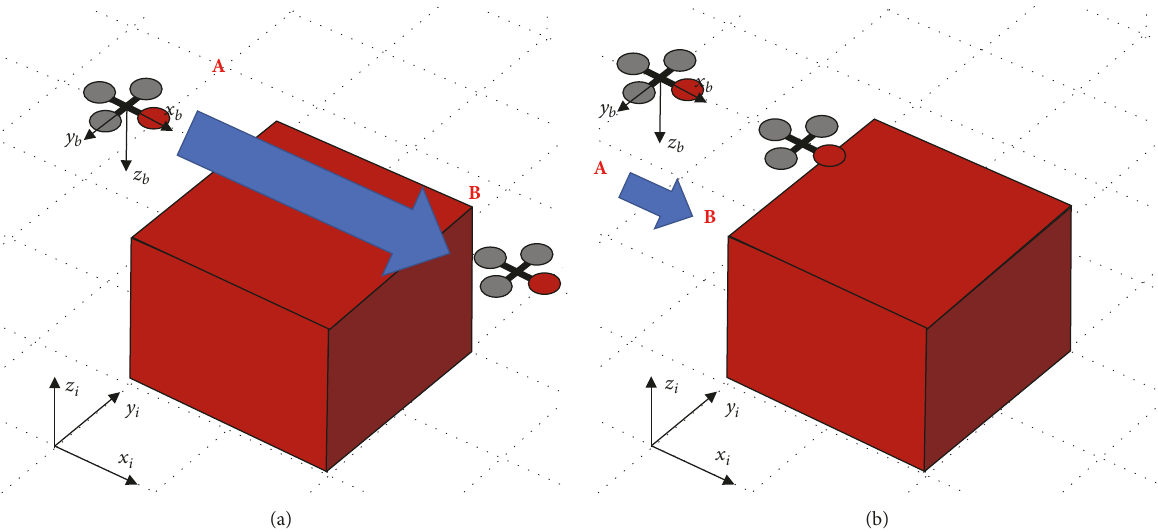
Figure 11: (a) Case 1: flying over an obstacle under the influence of the ground effect. (b) Case 2: hovering at a point with only one rotor under the influence of ground effect.